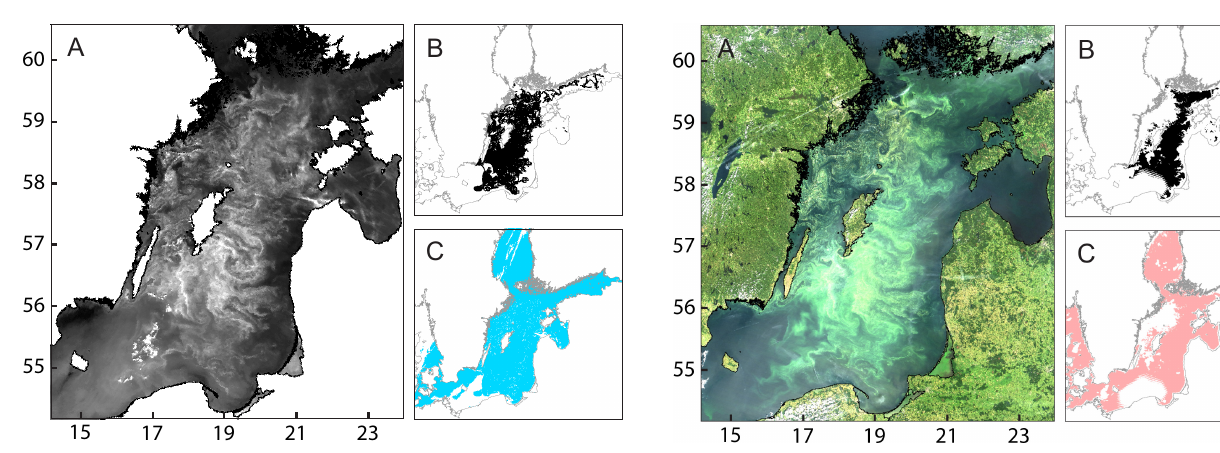
Figure 6. Example of cyanobacteria detection on MODIS-Terra im- agery of central Baltic Sea on 11 July 2005. (A) Quasi true-color im- age using bands 1 (red), 3 (blue), 4 (green). (B) Detected cyanobac- teria accumulations (black). (C) Valid ocean areas